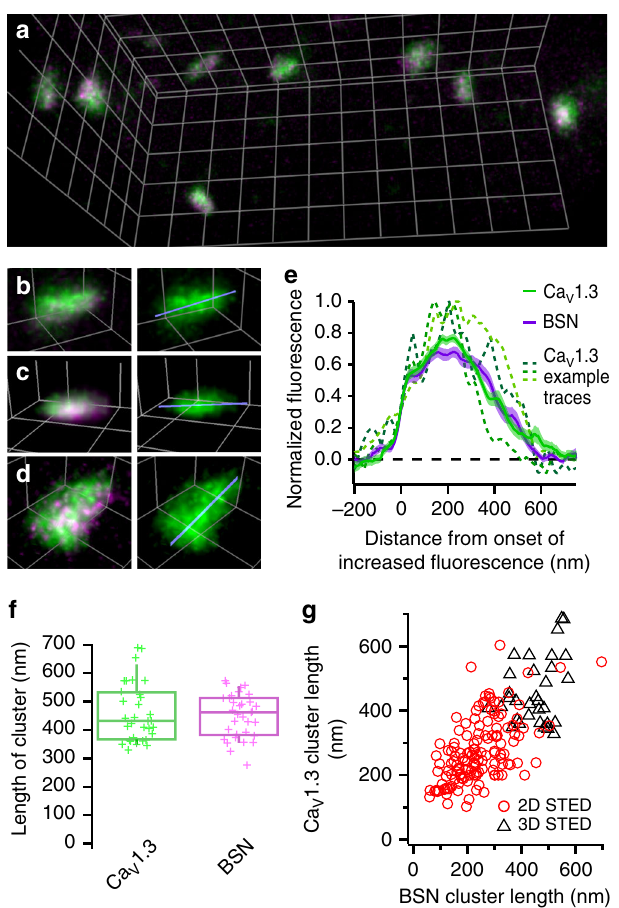
Fig. 2 3D nanoscale anatomy of IHC Ca 2+ -channel clusters. a – d Volumetric displays of representative examples of Ca V 1.3 (green) and bassoon (magenta) immuno fl uorescence at IHC AZs, acquired with 3D-STED microscopy. In the right panels of b – d , Ca V 1.3 immuno fl uorescence is shown in isolation, blue lines indicate the 3D line pro fi le plots used to estimate the length of the clusters by measuring the full-width at half- maximum of the line pro fi le ( e ), here 455 nm ( b ), 389 nm ( c ), and 535 nm ( d ). Grid distance: 500 nm. e Average display of line pro fi les plotted through the 3D data from Ca V 1.3 (green) or bassoon (BSN, magenta) clusters along the long axis of Ca 2+ -channel clusters ( n = 33 AZs from N = 2 mice), with representative examples of line pro fi les from individual clusters of Ca V 1.3 shown as dotted green lines. f Average length of the clusters of Ca V 1.3 channels (green) or bassoon (magenta), as measured from the full width at half maximum of the line pro fi les summarized in e . Crosses indicate individual data points. g Comparison of the lengths of associated Ca V 1.3- and bassoon-clusters as measured by fi tting a 2D Gaussian function (2D-STED) or by measuring the FWHM of a 3D line pro fi le (3D-STED) indicates a strong correlation between both measures (Pearson ’ s correlation coef fi cient of 0.71 for the combined data